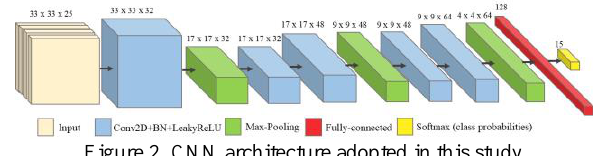
Figure 2. CNN architecture adopted in this study.